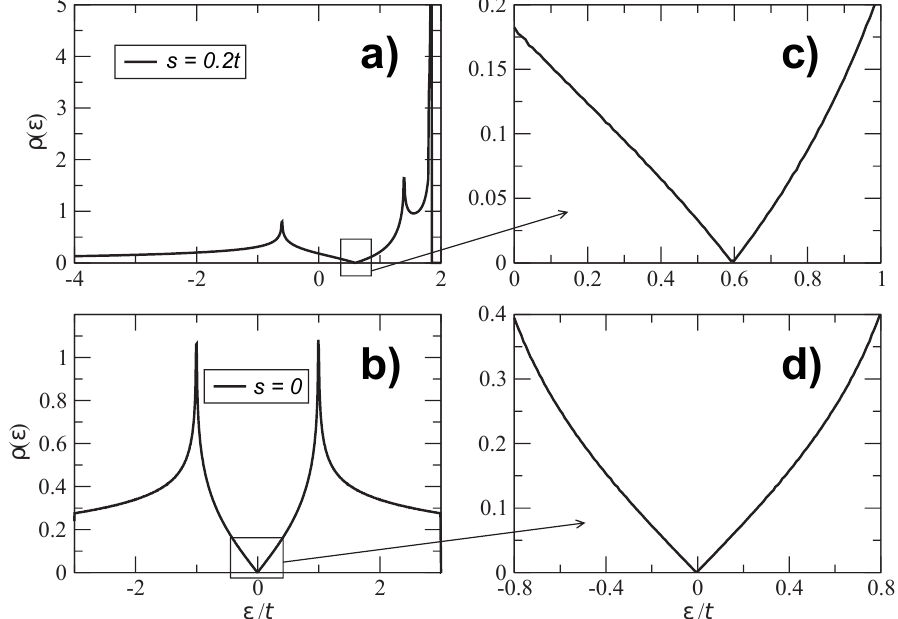
Figure 10. DOS of graphene calculated by assuming ( a ) s (cid:54) = 0, and ( b ) s = 0 in Equation (19). ( c , d ) Detailed plot of energy near (cid:101) 2 p . Reprinted with permission from Ref. [23]. Copyright (2009) American z Physical